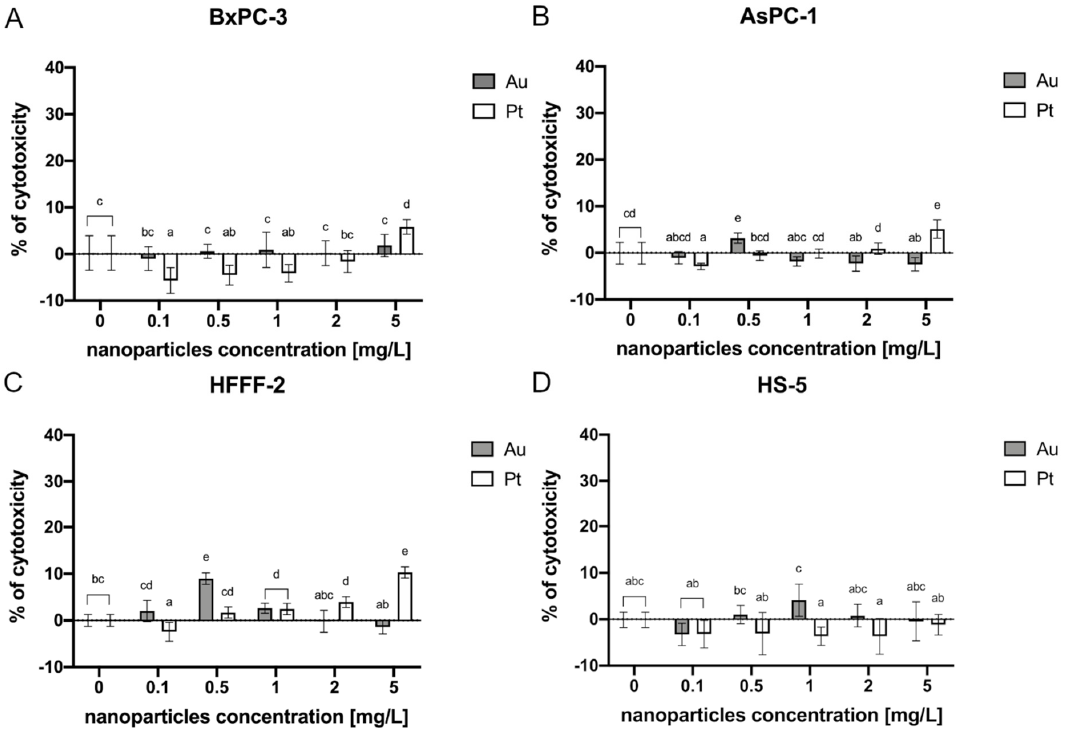
Figure 2. Membrane integrity of the cells after a 24-h incubation period with metallic NPs as determined by an LDH assay. The results are presented as the percentage of cytotoxicity (mean with standard deviation). Different letters above the columns indicate statistically significant differences between the groups ( p ≤ 0.05). Capital letters refers to the different cell lines: ( A ) BxPC-3; ( B ) AsPC-1; ( C ) HFFF-2; and ( D ) HS-5.